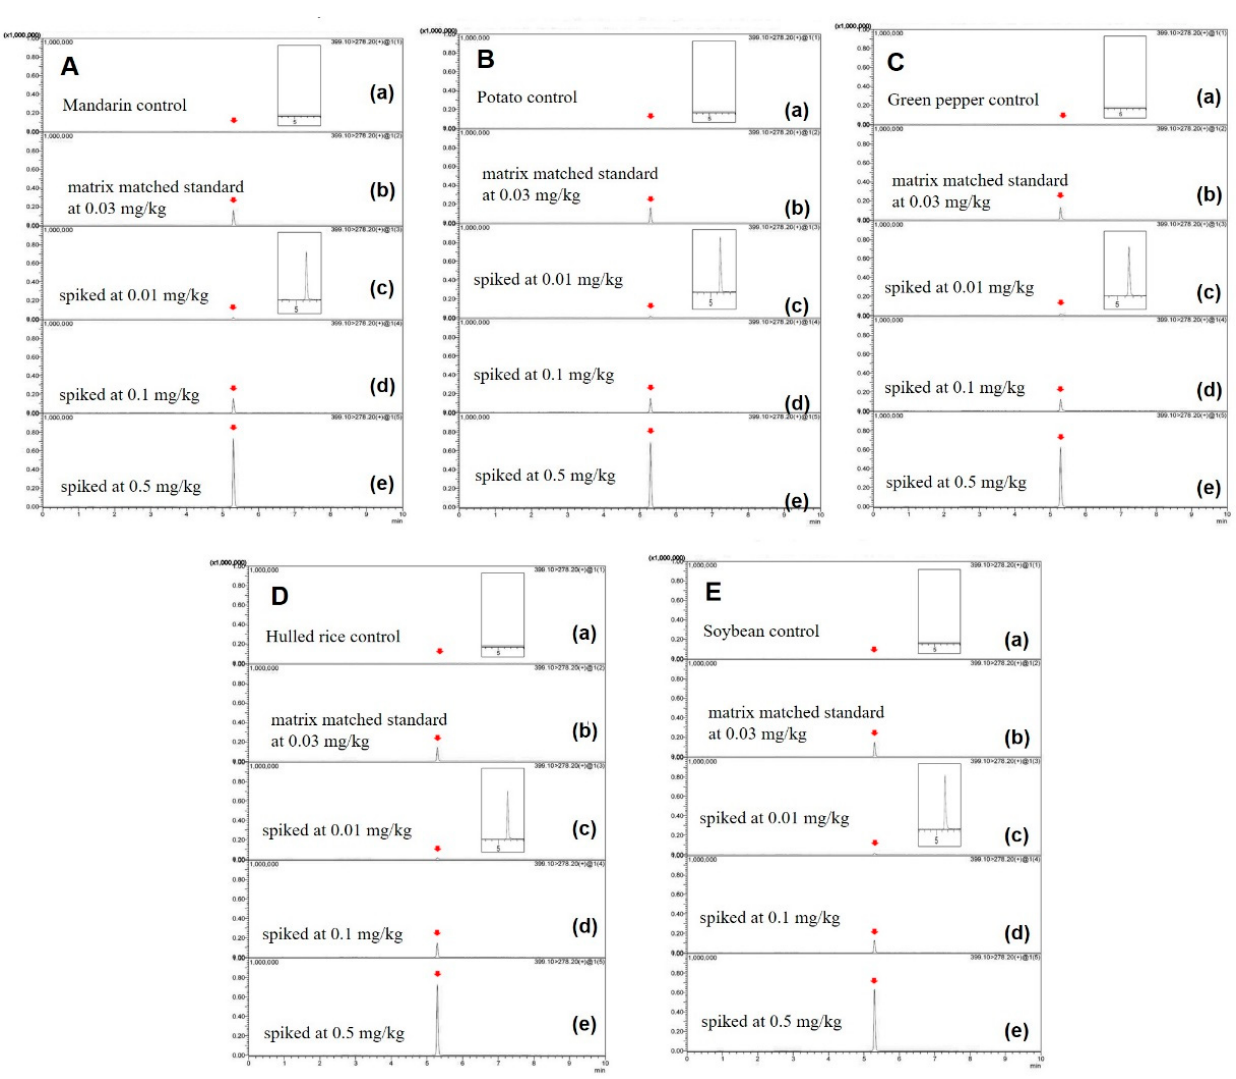
Figure 3. Representative MRM (quantification ion 399 > 278) chromatograms of triflumezopyrim residue in ( A ) mandarin, ( B ) potato, ( C ) green pepper, ( D ) hulled rice, and ( E ) soybean: ( a ) control of each food, ( b ) matrix-matched standard at 0.03 mg/kg, ( c ) spiked at 0.01 mg/kg, ( d ) spiked at 0.1 mg/kg, and ( e ) spiked at 0.5 mg/kg.